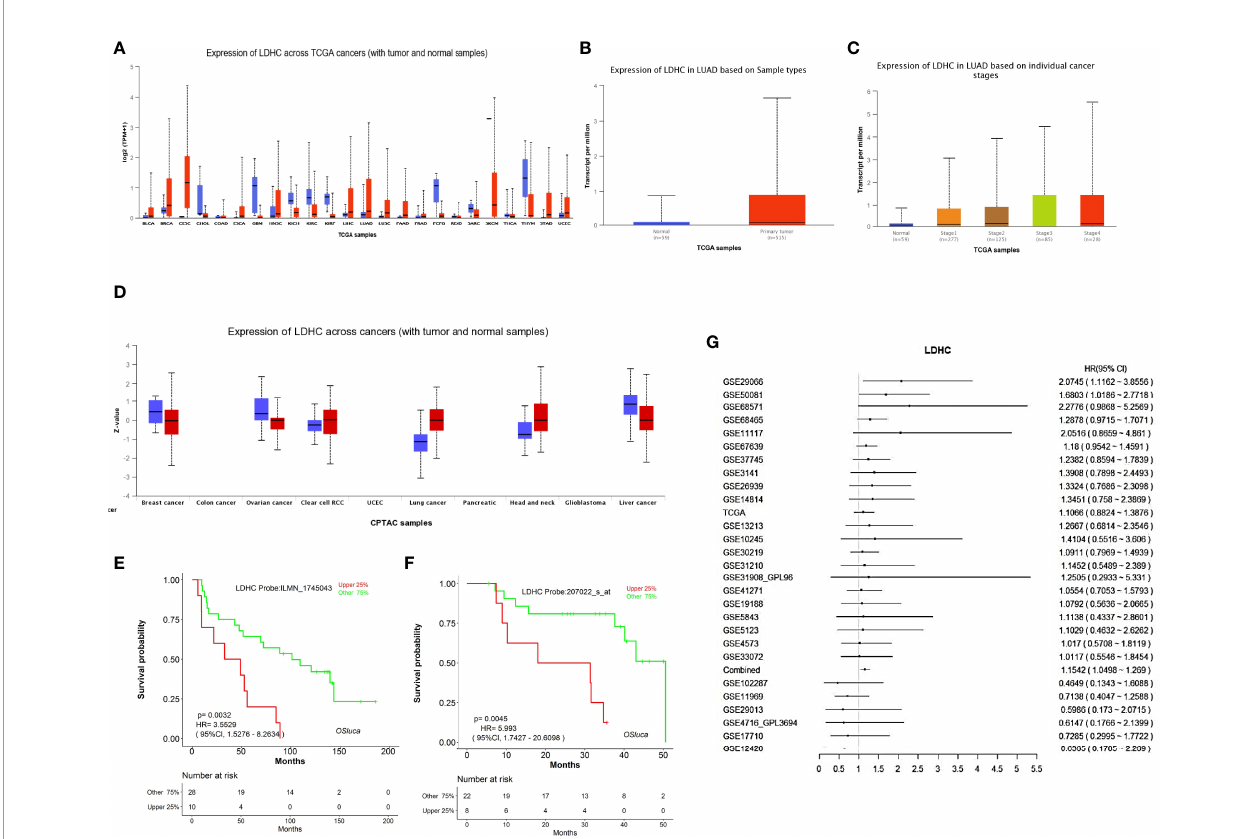
FIGURE 2 | The expression and prognostic value of LDHC /LDH-C4 in LUAD were analyzed based on an online database. (A) Pan-cancer view of LDHC mRNA in the UALCAN database. Expression of LDHC in LUAD tissue based on (B) sample types (LUAD vs. normal control) and (C) clinical stages in UALCAN. (D) Pan- cancer review of LDH-C4 protein expression using UALCAN, and all lung cancer samples were from LUAD cases ( n = 111). The plotted survival curves for (E) OS and (F) PFS were drawn by the LOGpc database. (G) HR forest map of LDHC expression and lung cancer prognosis analyzed using the LOGpc platform (combined HR =